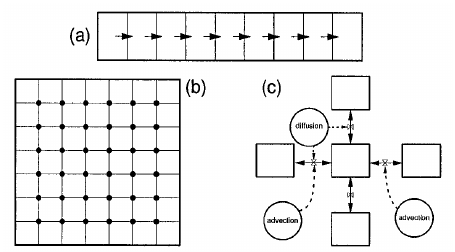
Fig. 1. (a) Flow between imaginary compartments in a continuous one-dimensional system. (b) Discrete grid system used in two-dimensional transport models. (c) A close-up of five grid points showing the similarity to compartment